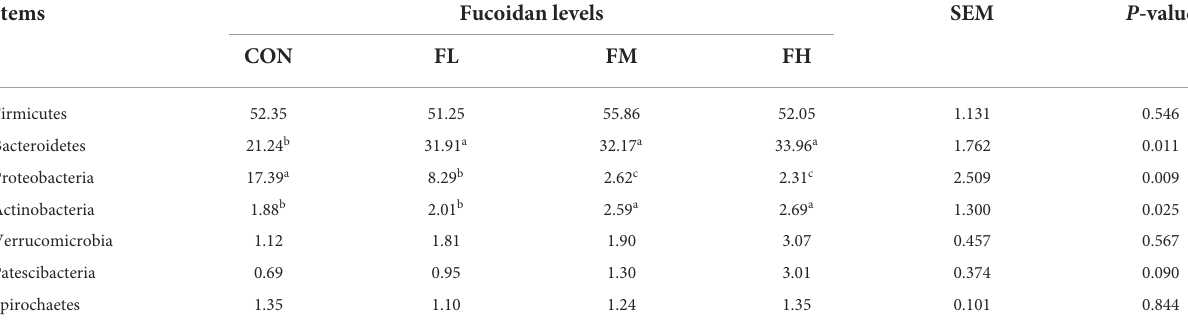
TABLE 3 The effects of fucoidan on the major bacterial phyla in the compositions of the ceca (average relative abundance ≥ 1% in at least one group)